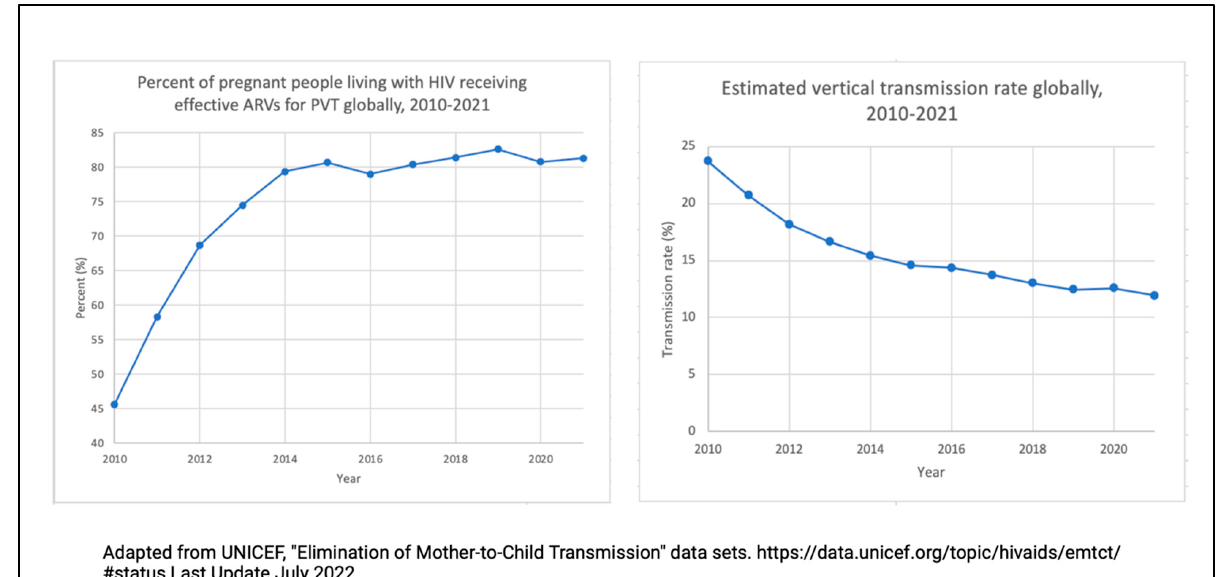
Figure 2. Line graphs illustrating the percentage of HIV-positive people on antiretroviral medication in terms of the prevention of VT from 2010 to 2021 ( left ) and the estimated vertical transmission rate globally from 2010–2021 ( right ).